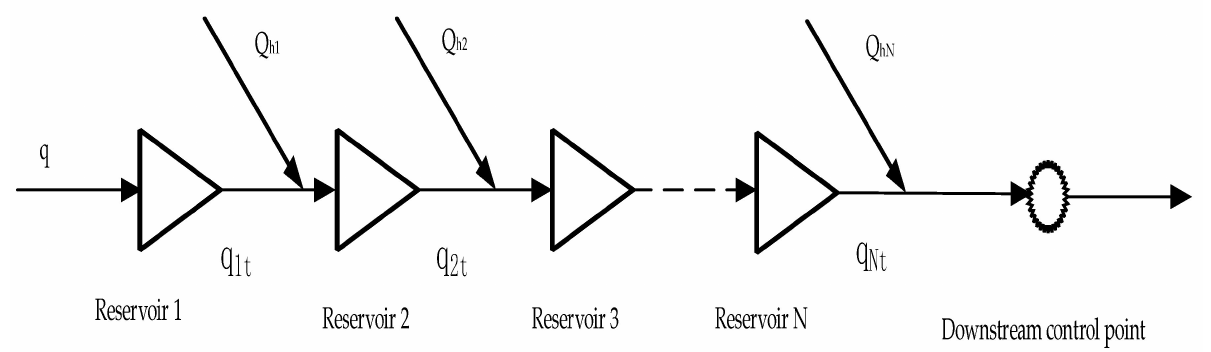
Figure 1. Diagram of N-level cascade